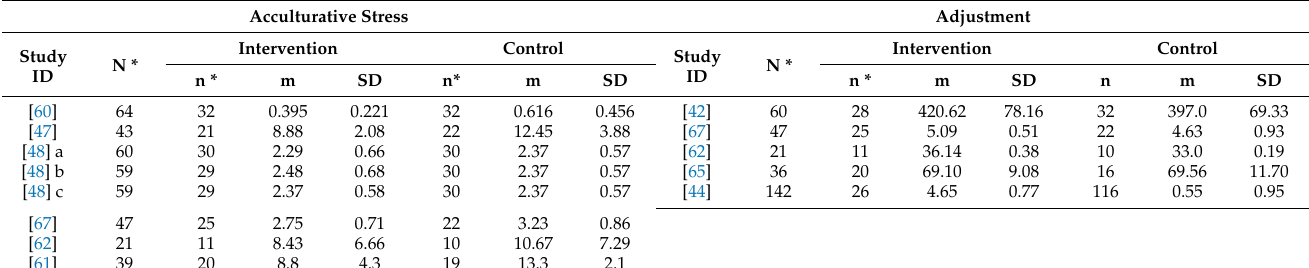
Table A4. Quantitative data of acculturative stress and adjustment of international